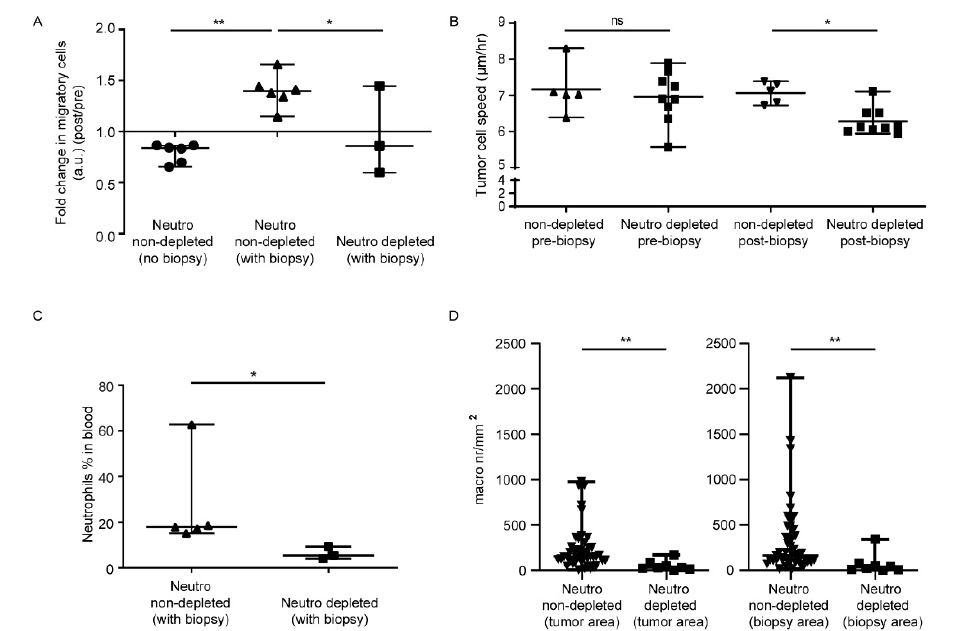
Figure 2. Biopsy induces a neutrophil-dependent increase in the in vivo motility of mouse glioma tumor cells. ( A ) Direct comparison of the fold changes (post day 13/pre day 11) in percentage of migratory glioma tumor cells before/after biopsy in 3 neutrophil-depleted biopsied mice to that of six control mice with and six control mice without biopsy from Alieva et al. [9]. Tracks from multiple imaging positions within one mouse were pooled; * p < 0.05, ** p < 0.01 in one way ANOVA. Bars represent median values with range. ( B ) Speed of migratory tumor cells of neutrophil depleted mice (before and after biopsy) compared to that of six control mice from Alieva et al. [9]. Separate imaging positions are shown. ( C ) Neutrophil percentage in the blood of neutrophil-depleted mice compared to that of control mice from Alieva et al. [9]. ( D ) Enumeration of the numbers of (F4/80 + ) macrophages/microglia by immunostaining of tumor tissue cryosections in biopsied mice without depletion from Alieva et al. [9] versus neutrophil-depleted mice. Areas with beads are labeled as biopsy area and random non-biopsied tumor tissue as tumor area.